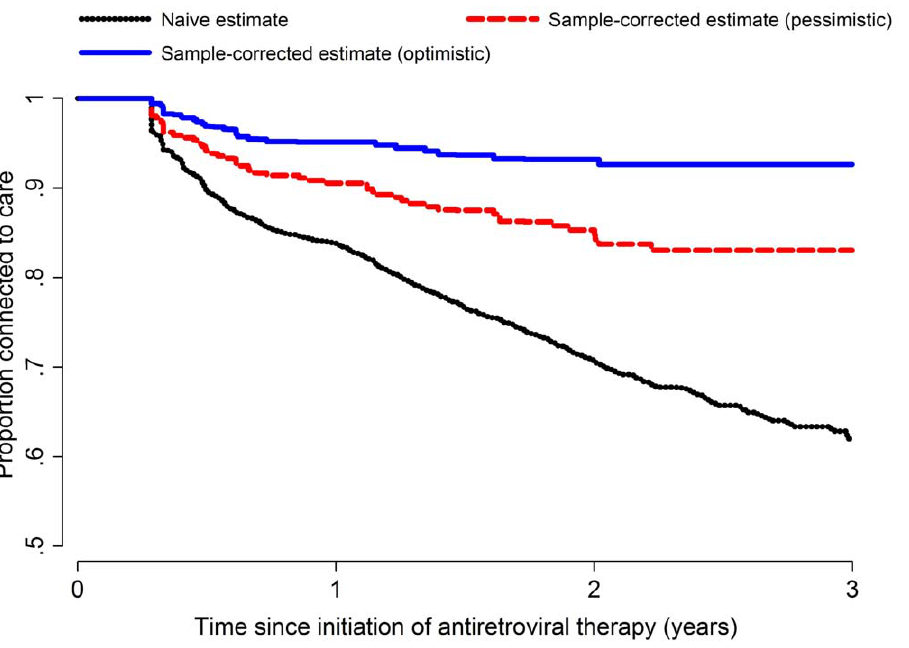
Figure 2. Naı¨ve and corrected estimates of ‘‘connection to care.’’ Connection to care uses a competing risk approach to estimate the probability of ART initiators access care and includes patients who are alive and continuing to use the clinic as well as those died while accessing care (i.e., who died shortly after their last clinic visit).